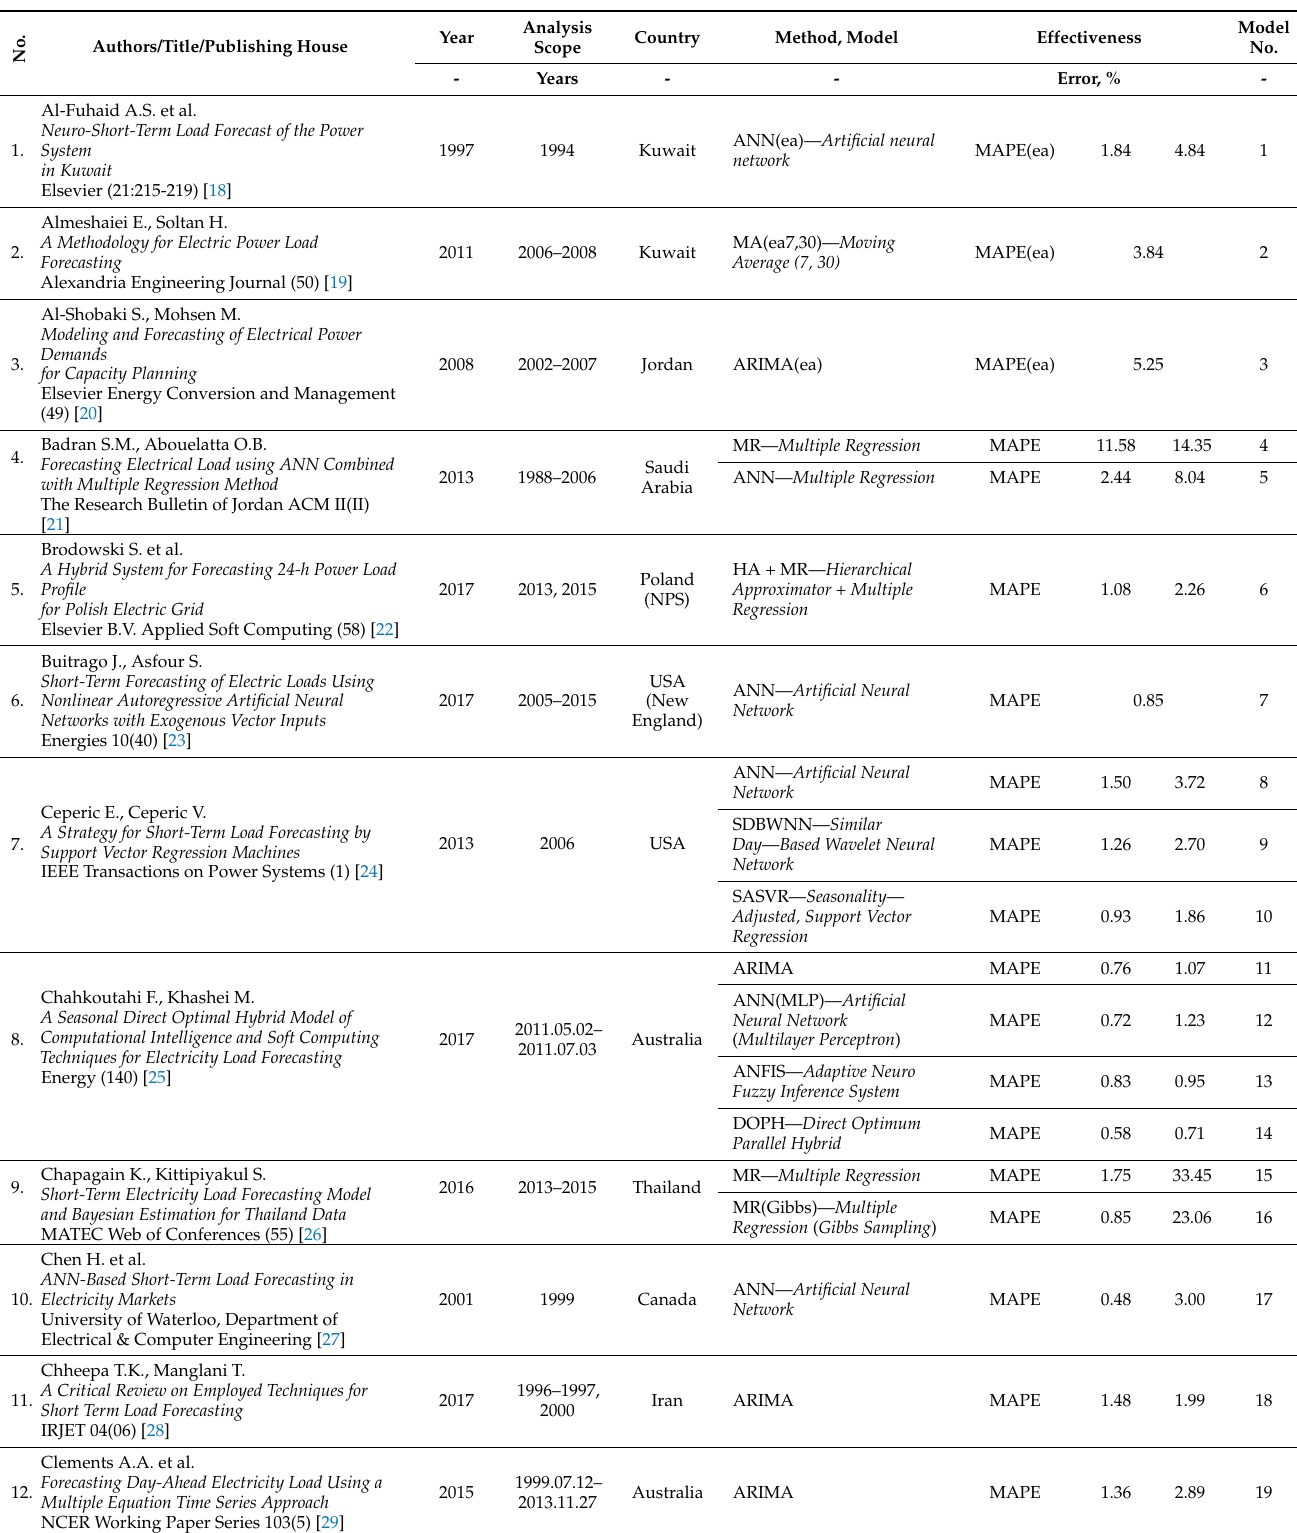
Table 1. The publications’ preview results in short-term power demand forecasting methods and models used for power